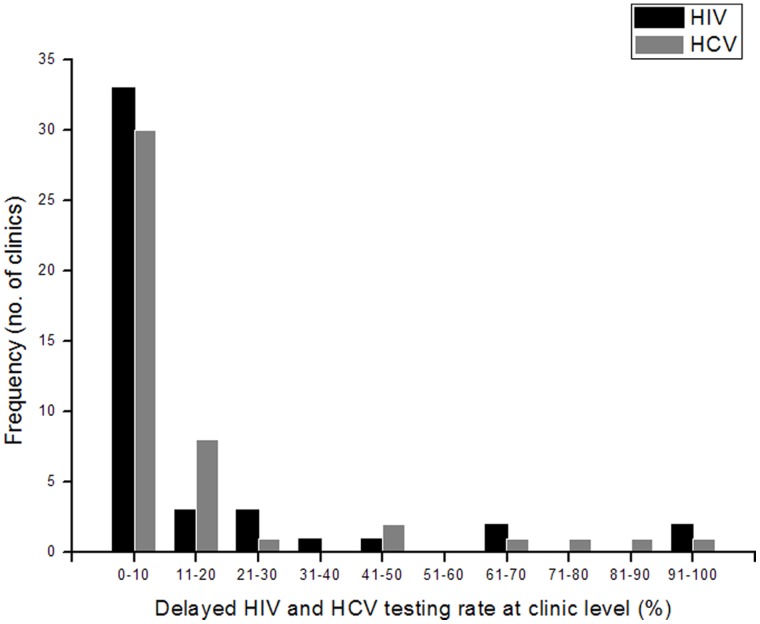
Distribution of delayed HIV and HCV testing rates at methadone clinics in Guangdong, China.